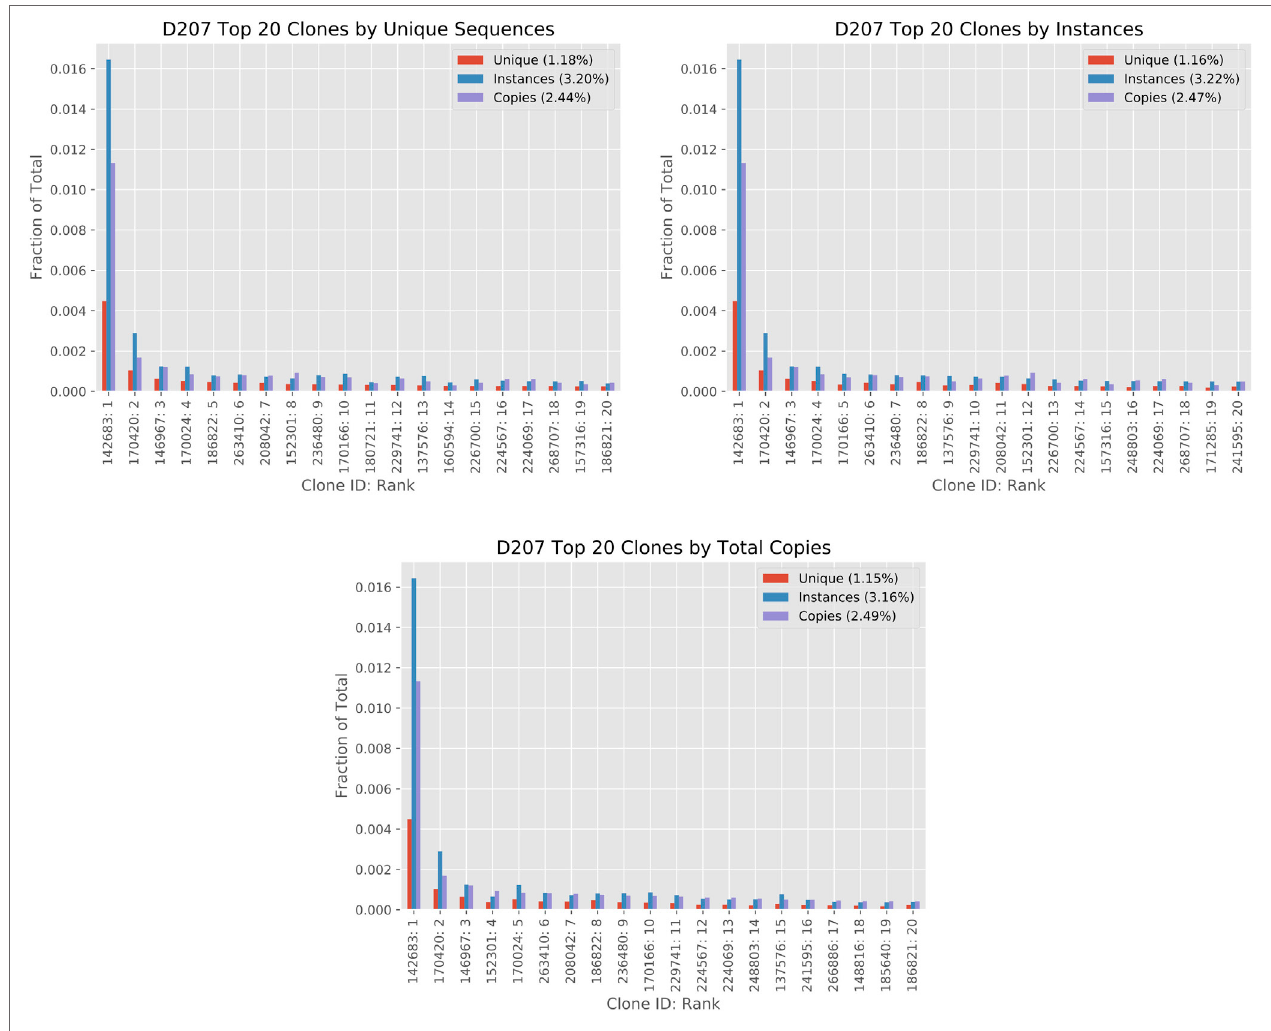
FIgUrE 5 | Analysis of top 20 clones by different clone size measures in D207. The top 20 clones are ordered in the three columns by total copies, instances, and unique sequences using the 19-library data set on D207. The x -axis shows the Clone ID (in ImmuneDB) followed by the rank. The clone size measures are given in fractions. The percentage within each chart legend indicates the sum of the top 20 ranked clones in the chart for each measure (please refer to the text for clone size